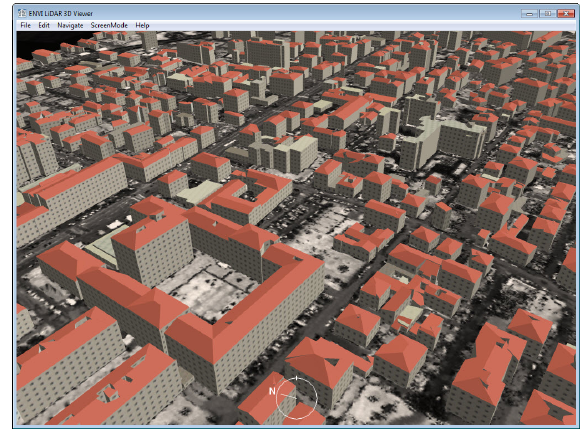
Figure 11: 3D Viewer interface: details from the study area